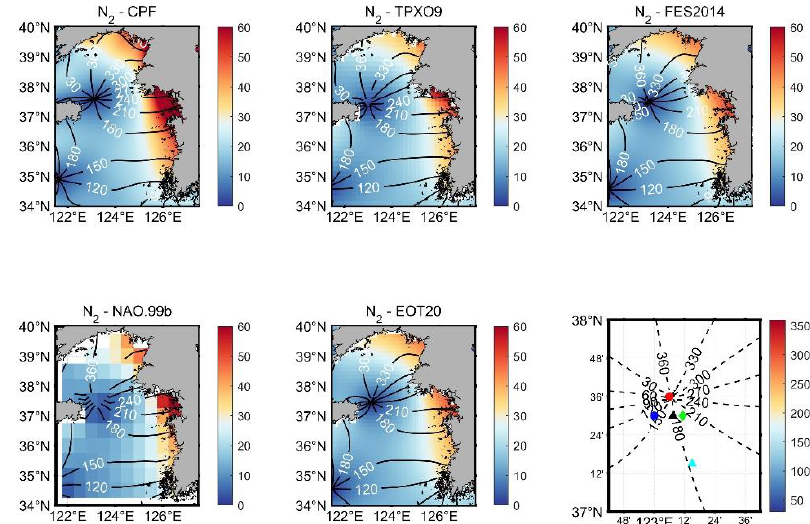
Figure 8. The cotidal charts of the O 1 constituent from the CPF method and the TPXO9, FES2014, NAO.99b and EOT20 models (unit: cm).